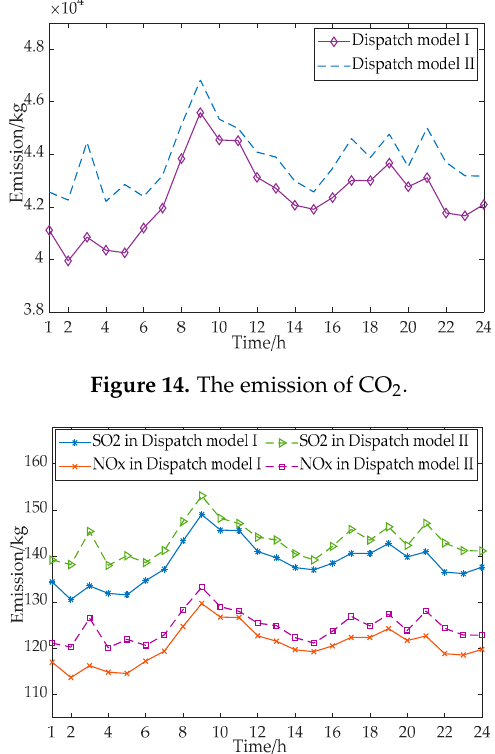
Figure 15. Comparison of the emissions of SO 2 and NO x .